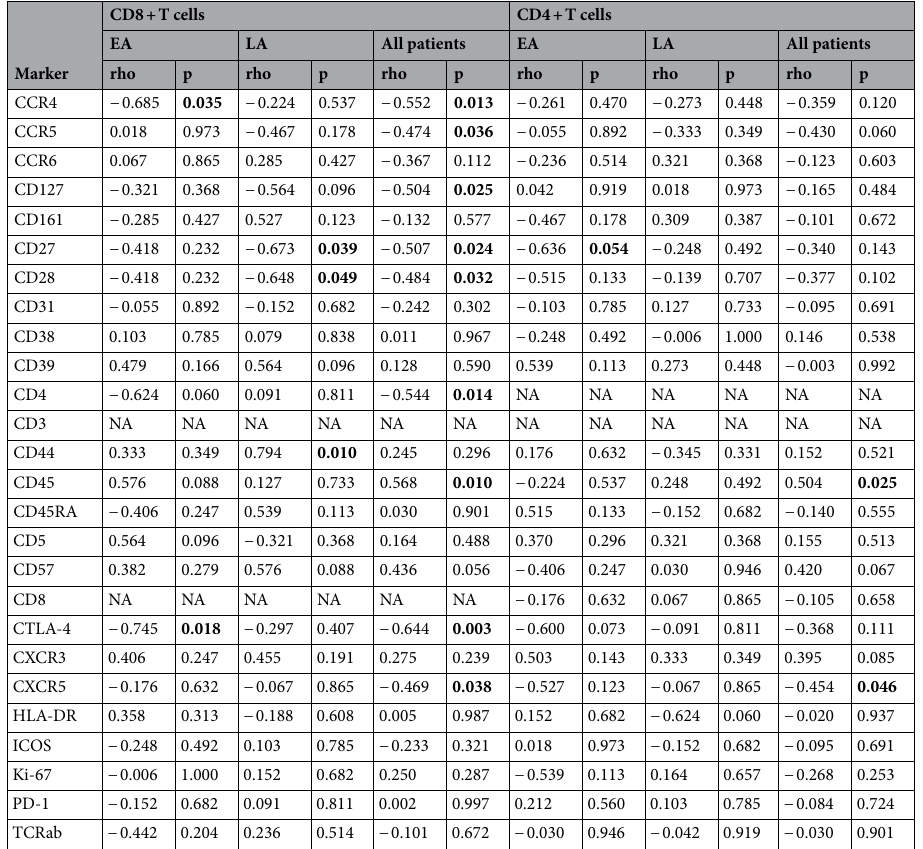
Table 2. Correlation of the virus reservoir with CyTOF markers´ expression on CD8 + and CD4 + T cells isolated from patients starting ART at the acute and chronic phase of infection. Non T cell-specific markers, CD19 and CD11c, were excluded. EA early ART at acute infection, LA late ART at chronic infection, NA not